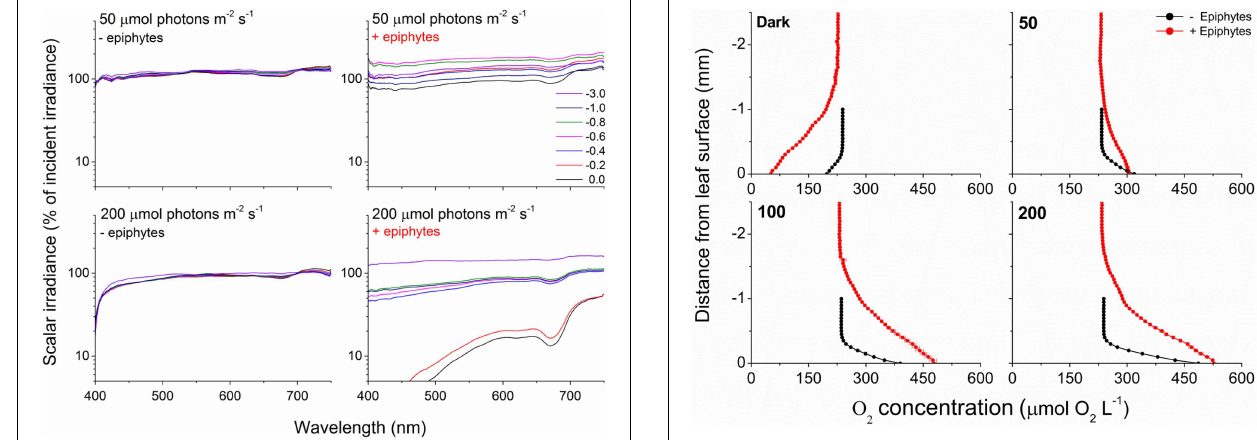
FIGURE 3 | Spectral scalar irradiance measured over Z. marina leaves under an incident irradiance of 50 and 200 µ mol photons m − 2 s − 1 with- (right panels) and without epiphytes (left panels). Colored lines represents spectra collected at the given depths in mm above the leaf surface expressed as % of incident irradiance on a log-scale. n = 3 ; leaf level replicates.